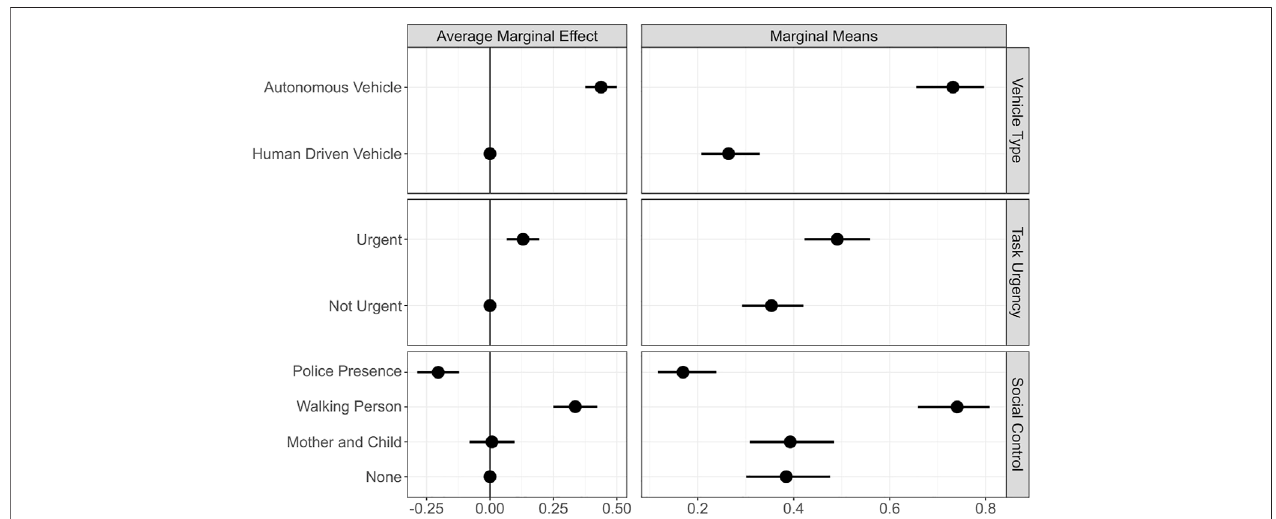
FIGURE 6 | Average marginal effects and marginal means for general crossing. Note: left plot shows the average marginal effects (AME) of our three experimental factors in reference to their baseline factor levels. The vertical line represents the effect of the reference level. The right column reports the marginal means (MM) for the different factor levels on crossing probabilities, holding the other factors constant at their proportions. Points indicate AME/MM, horizontal lines the 95% CIs. Effects based on results of GLMM.